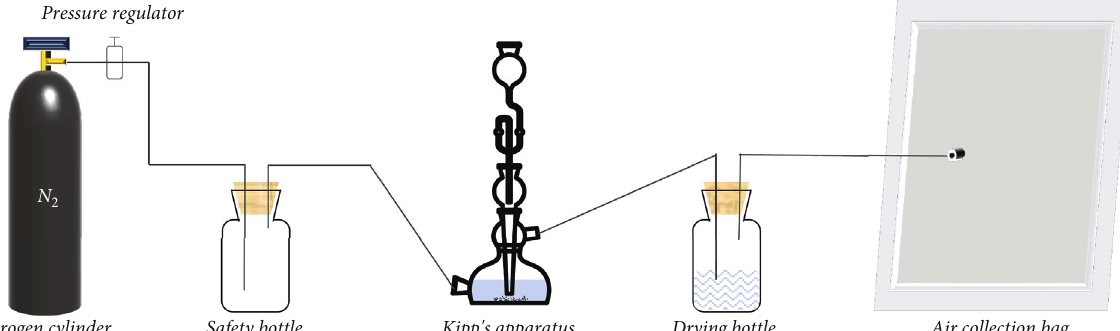
Figure 1: Flow diagram of gas production.